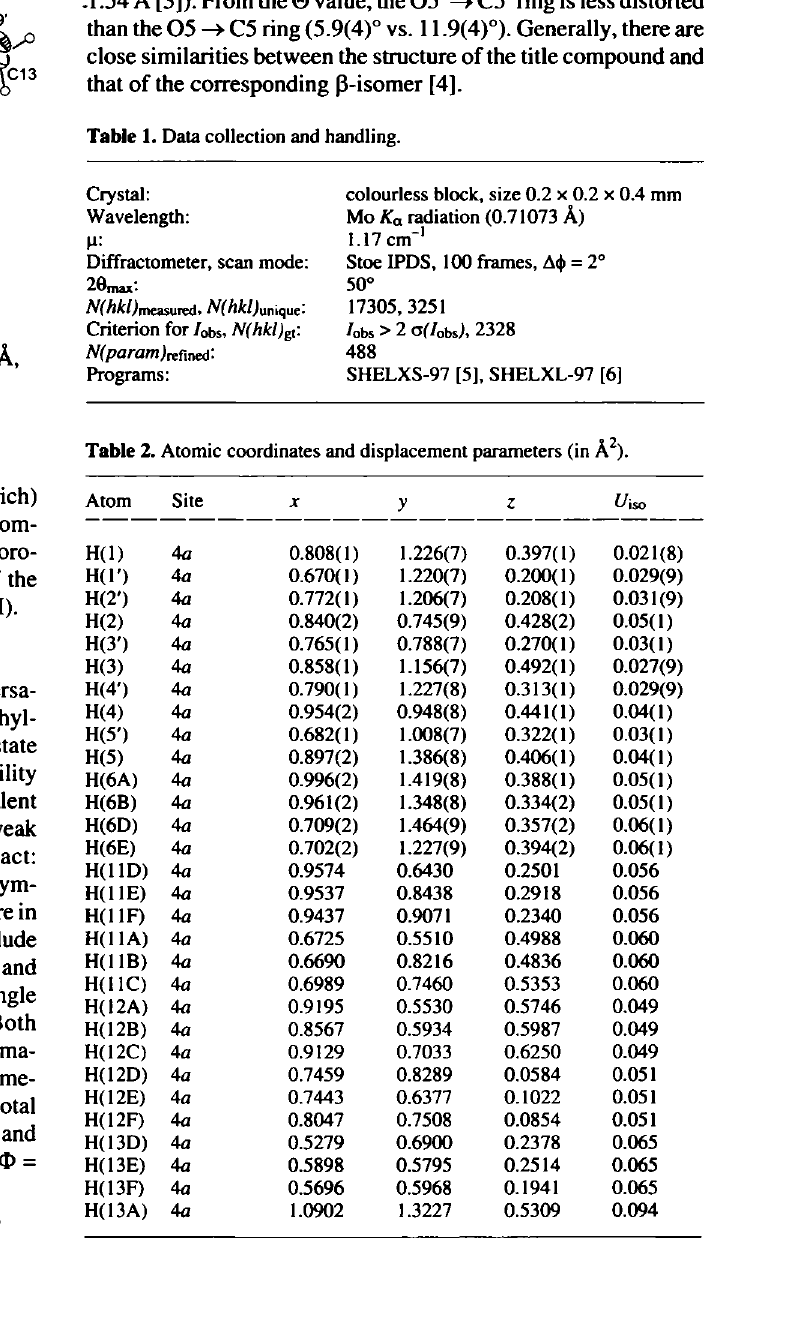
Table 1. Data collection and handling.